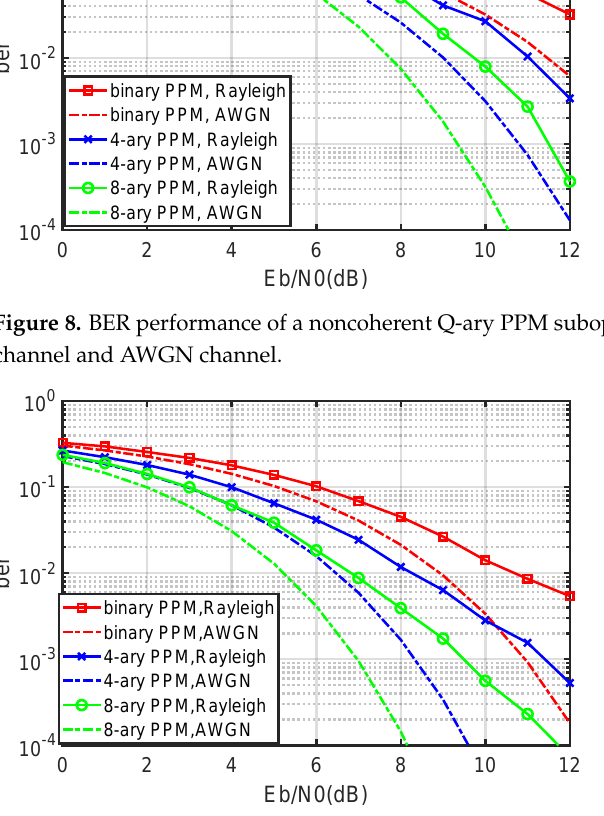
Figure 9. BER performance of a noncoherent Q-ary PPM optimal receiver in the Rayleigh fading channel and AWGN